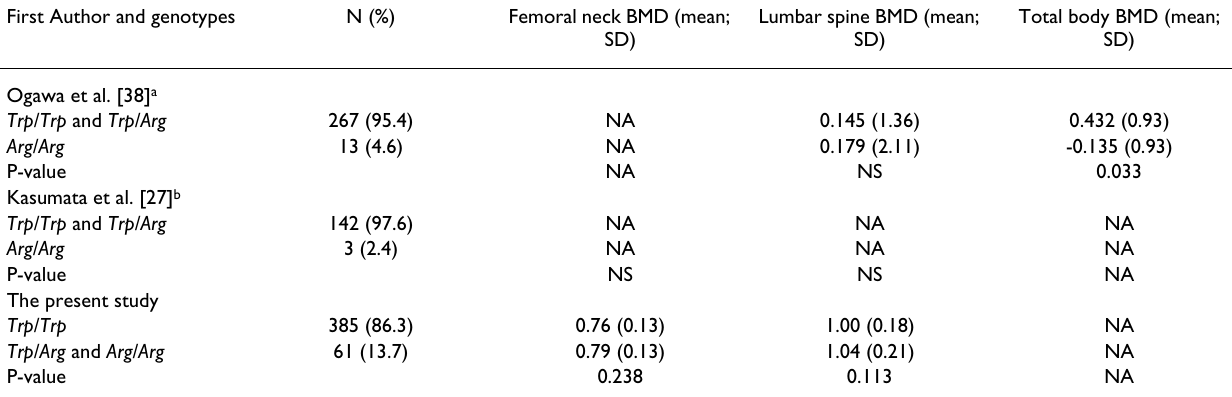
Table 6: β 3AR genotypes and bone mineral density: summary of previous and present studies First Author and genotypes N (%) Femoral neck BMD (mean;